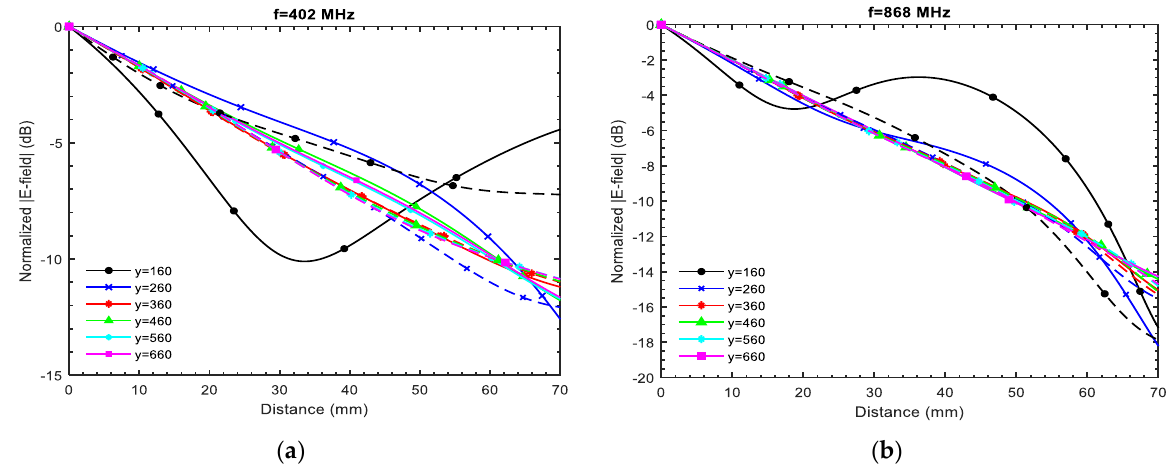
Figure 5. Normalized electric field vs. insertion distance (z axis) computation using CST for a phantom dimension of (355 × Y × 255) mm. H polarization (continuous line) and V polarization (dashed line): ( a ) f = 402 MHz and ( b ) f = 868 MHz.